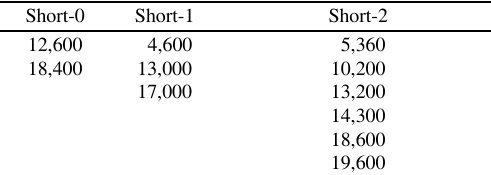
Eigen frequencies (Hz) of axial mode up to 20,000 Hz obtained from the short structural models